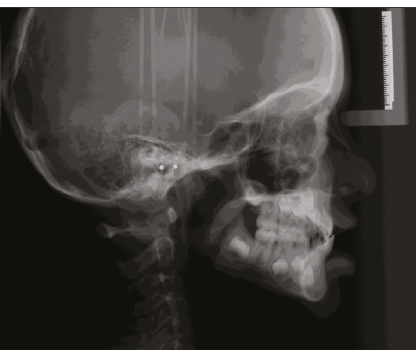
Figure 3: Pretreatment cephalograph.